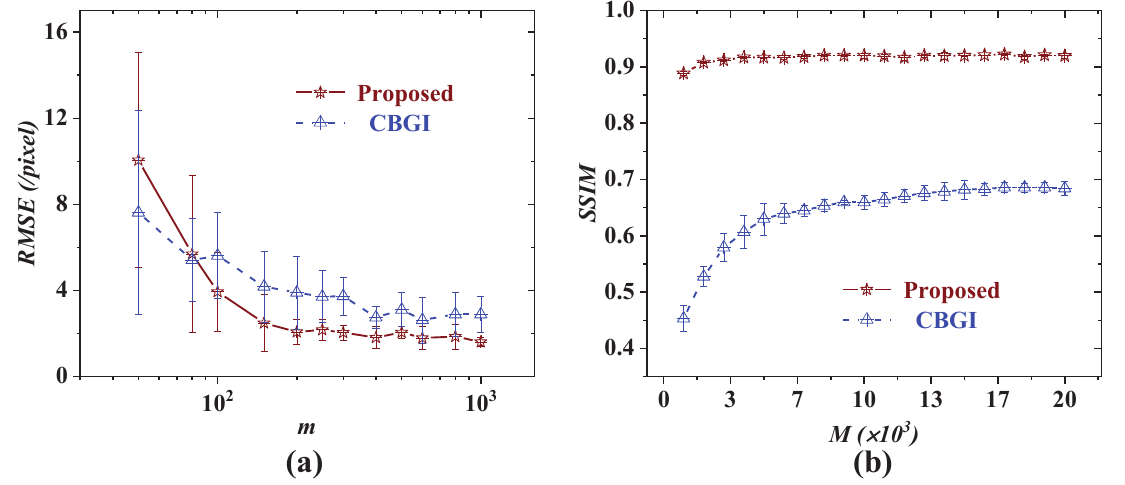
Figure 3. Comparing the different object-locating methods on ( a ) the RMSE of the object displacement against the measurement number m per image period; ( b ) SSIM of the reconstructed images against the total measurement number M